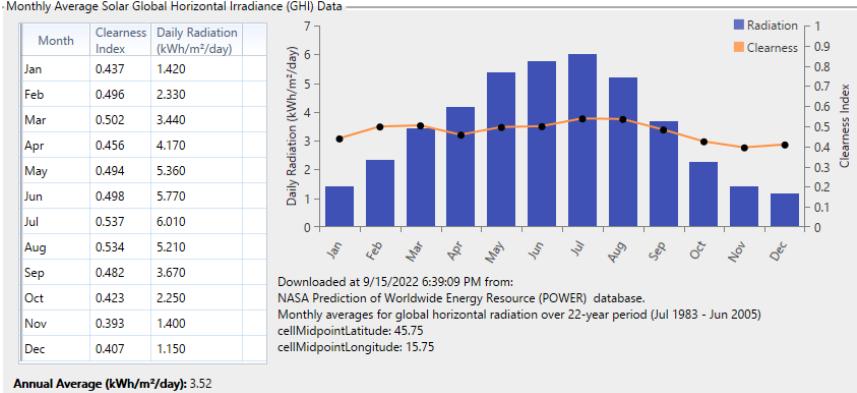
Figure 3. Monthly Average Solar Global Horizontal Irradiance (GHI) Data.